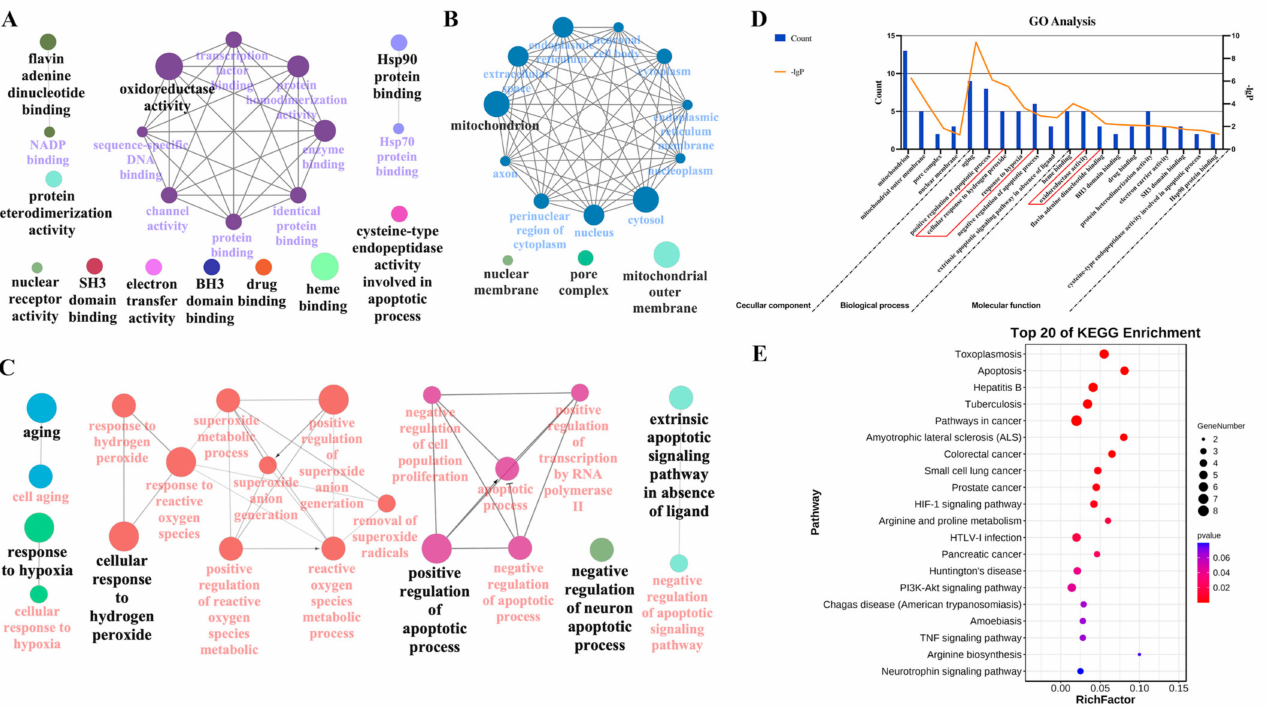
Figure 2. GO and KEGG enrichment analyses of galangin in the treatment of PD. ( A ) Visualization of 20 terms of molecular function enrichment analysis. ( B ) Visualization of 14 terms of cellular component enrichment analysis. ( C ) Visualization of 21 terms of biological process enrichment analysis. ( D ) GO analysis of core targets of galangin in the treatment of PD. Four terms of CC, 6 terms of BP, and 10 terms of MF showing the greatest enrichment of galangin-related processes are listed according to p values. ( E ) The top 20 KEGG pathways enrichment analysis involved in the potential treatment of galangin in